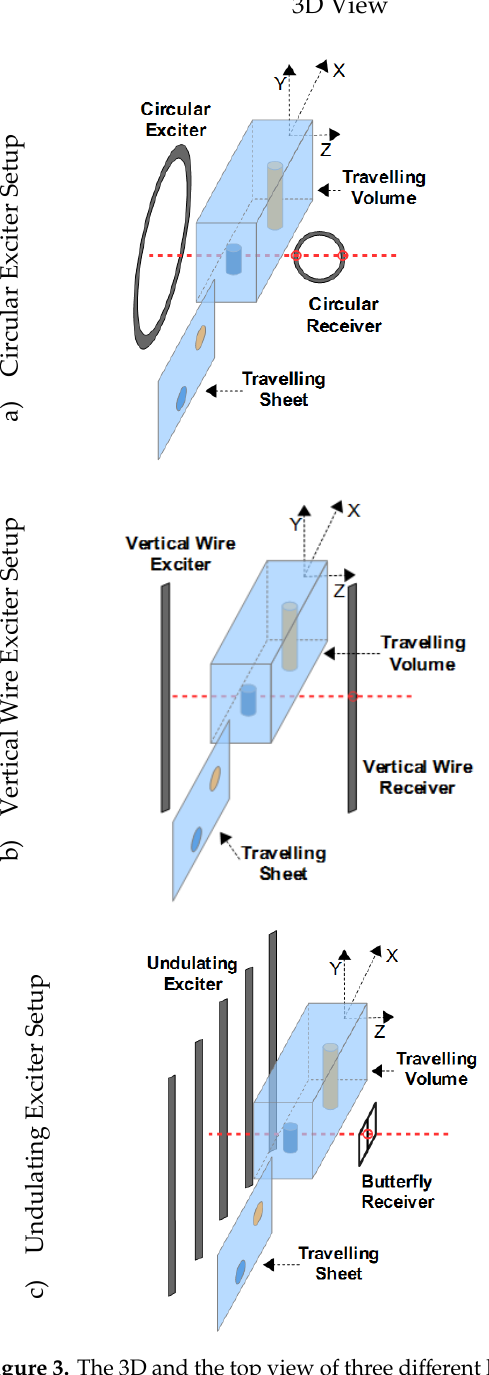
Figure 3 . The 3D and the top view of three different kinds of planar MIT setups are shown. A sheet-like or a volumetric object travels in the x-direction through the arrangement. ( a ) Circular exciter setup; ( b ) vertical wire exciter setup; ( c ) undulating exciter (undulator) setup.